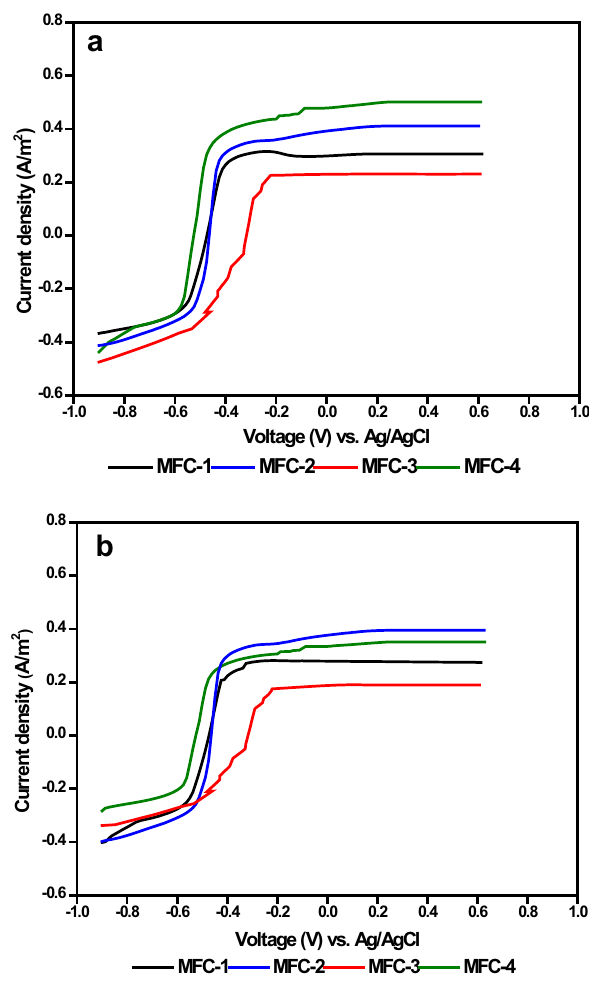
Fig. 5 Linear Sweep Voltammetry obtained after a six cycles, b ten cycles,